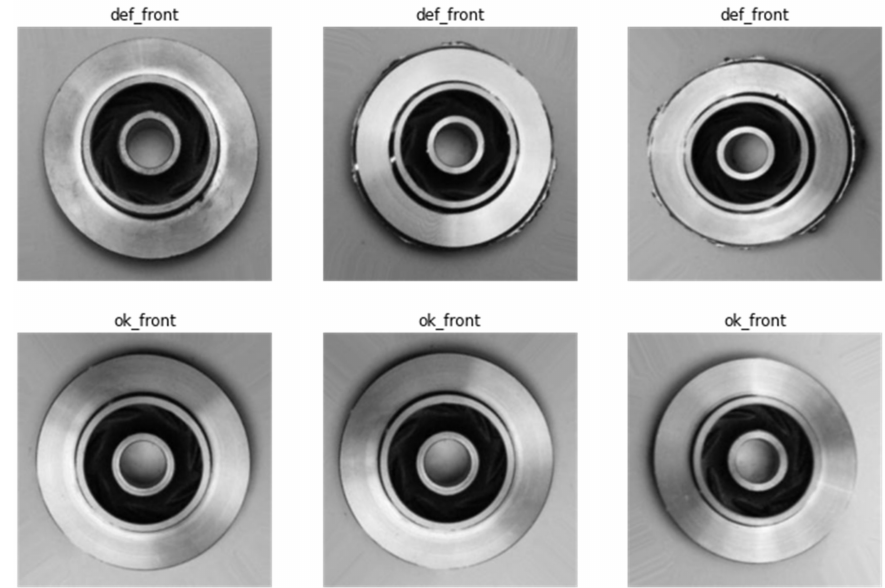
Figure 4. Sample images showing ‘defective’ and ‘okay’ stainless steel